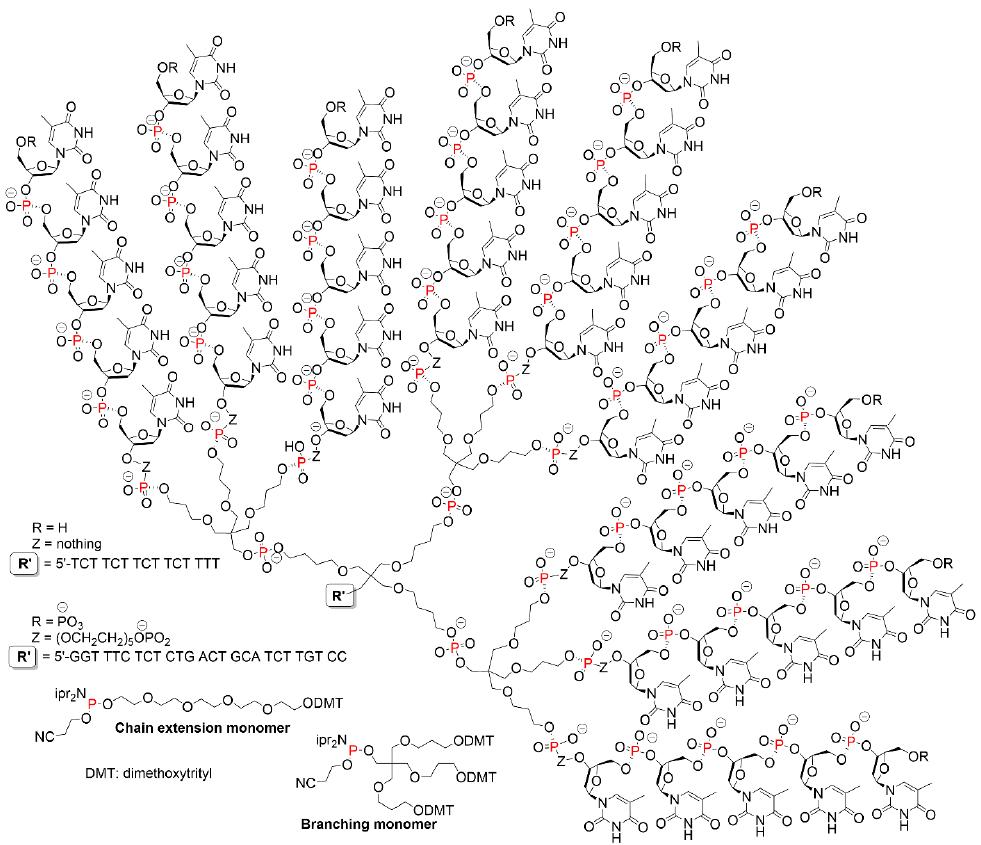
Figure 4. Phosphoramidite functionalized with pentaerythritol structure for branching and phosphoramidite functional- ized with an oligoethyleneoxide chain to reduce the density of packing. Structure of dendrons bearing an oligonucleotide at the core and pentathymidine on the